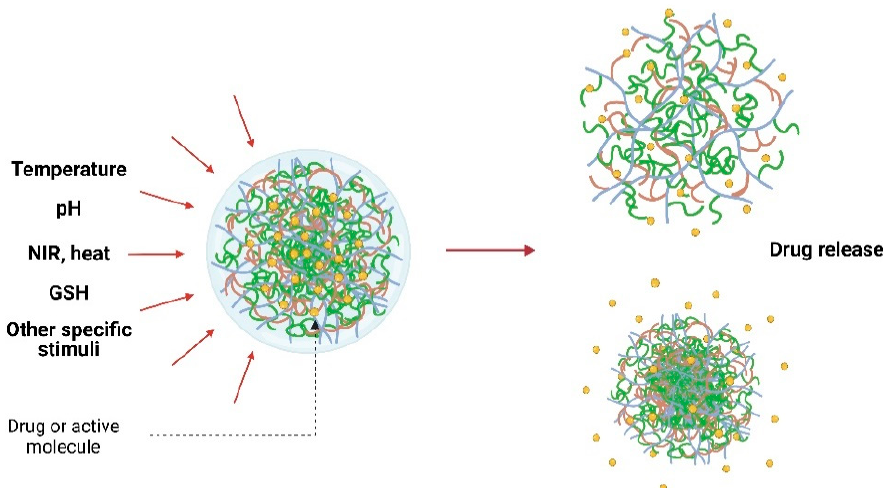
Figure 2. Shrink-swell behavior of nanogels after stimulation by specific stimuli resulting in targeted drug release.